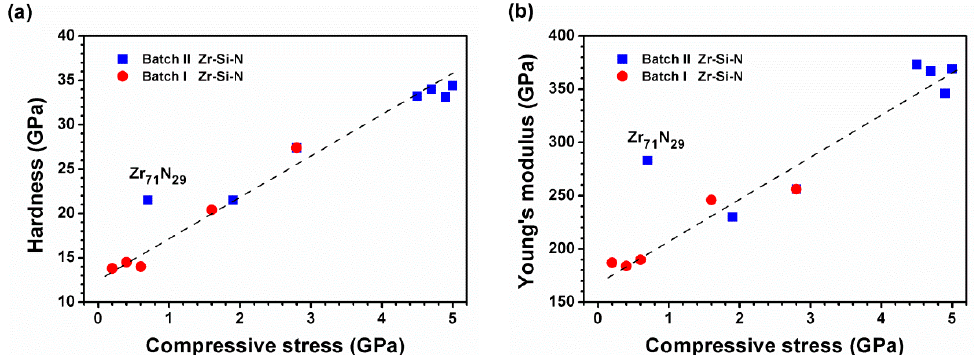
Figure 13. The relationships of ( a ) nanoindentation hardness and ( b ) Young’s modulus of Zr–Si–N films to their residual stress values.